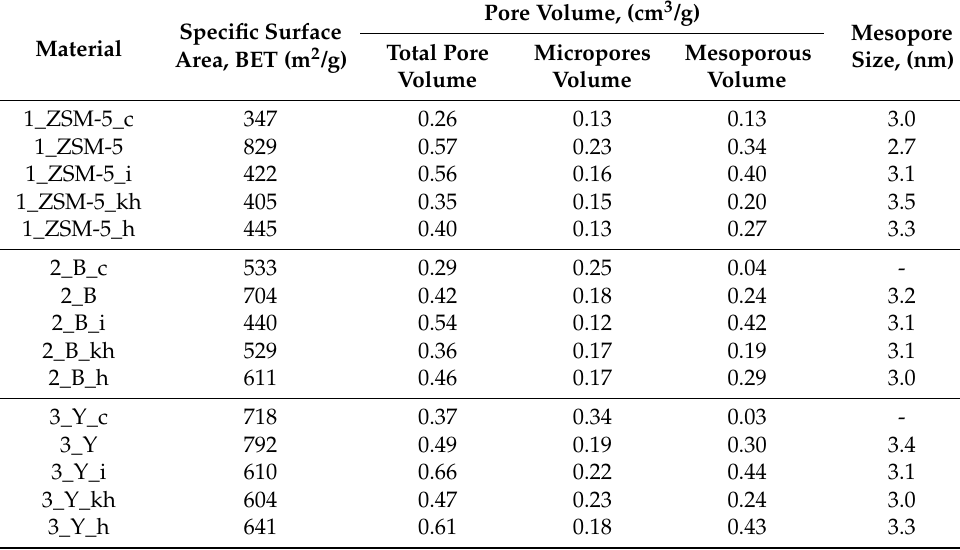
Table 3. Textural parameters of hierarchical zeolites prepared from commercial materials of ZSM-5, BEA ( β ), and FAU (Y)